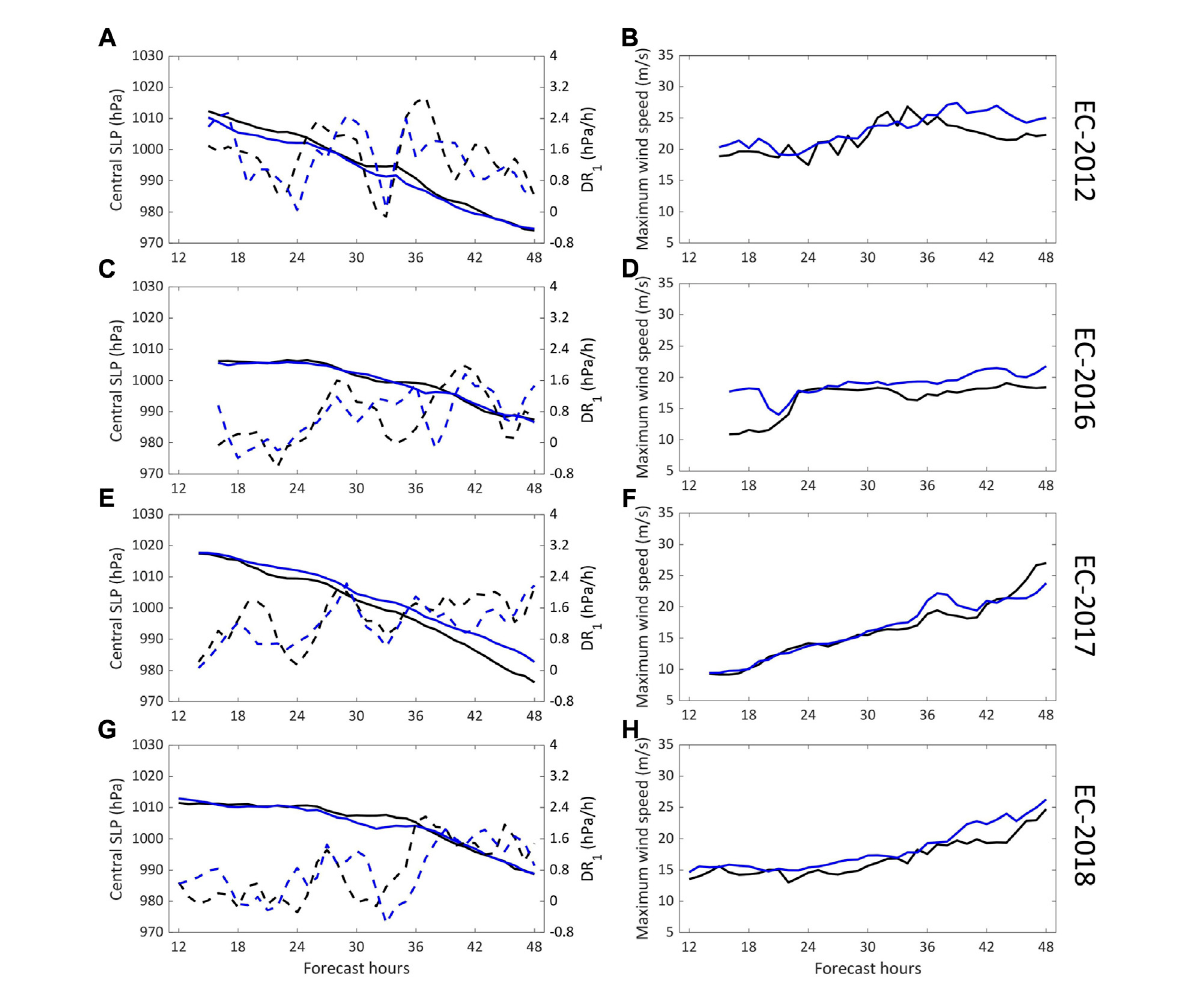
FIGURE 11 Comparison betweenthereanalysis and themodel.The leftcolumnshows thetime series of central SLP(solid lines) and hourly deepening rate (dashed lines) for thefour ECs. The right column shows thetime series ofthe maximum wind speed. Black and blue linesdenote the ERA5 reanalysis and Exp-Ctrl, respectively. The EC number for each row is marked